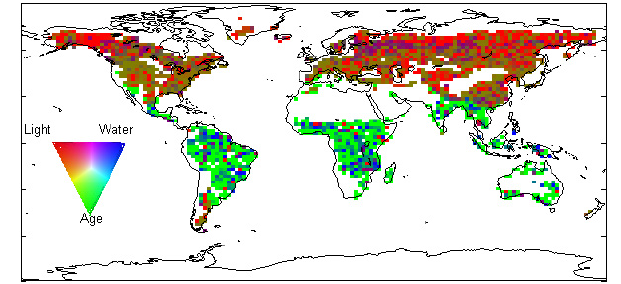
Fig. 12. Regions where leaf loss is driven by temperature and light availability (red), water (blue) or age (green) as predicted by the